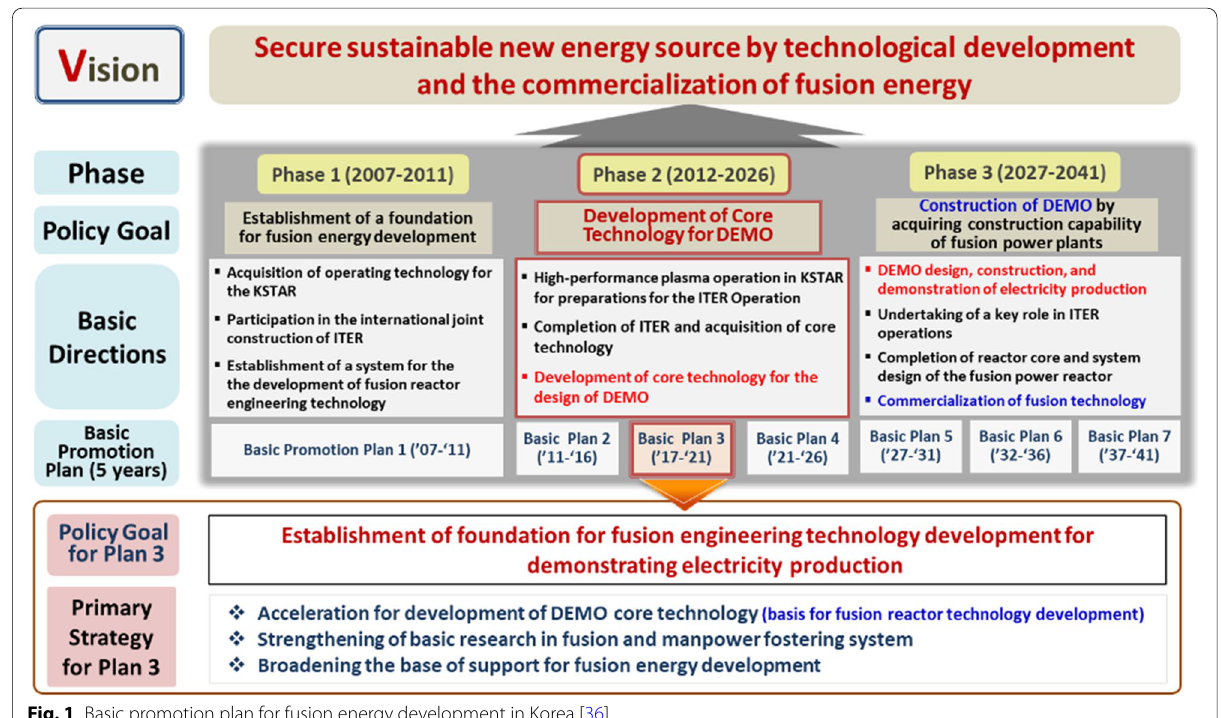
Fig. 1 Basic promotion plan for fusion energy development in Korea